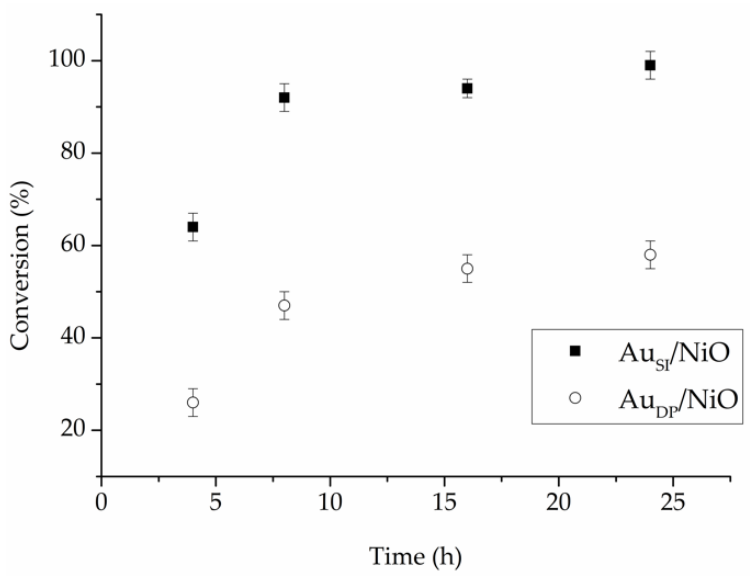
Figure 3. Reaction profile of Au SI /NiO and Au DP /NiO. Reaction conditions: isopropylamine (7 mmol), benzyl alcohol (7 mmol), total volume in xylene (30 mL), BA/Au: 250 mol %, 150 °C, 5 atm, N 2 , 1200 rpm.